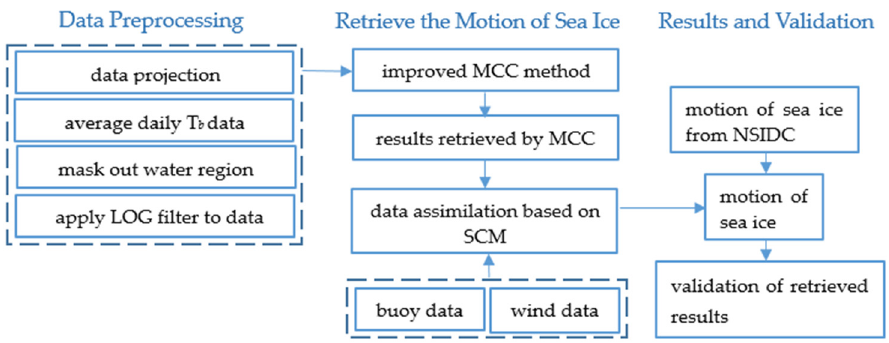
Figure 1. Flowchart of retrieving the sea ice motion and validation.